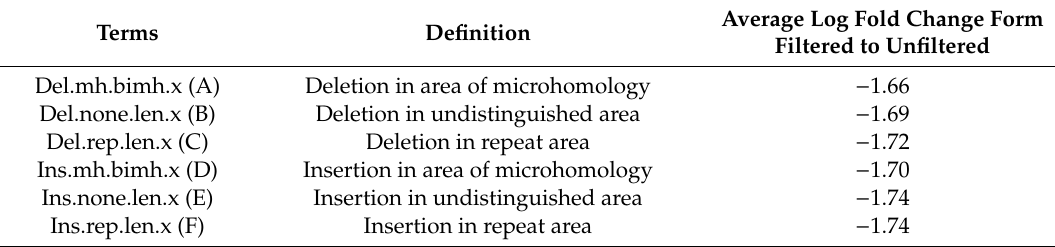
Figure 5. Mutational IR-induced signature plot (dataset 1). On the X-axis, the length and specific vicinity of InDels are represented, while the Y-axis (note differing scales) shows the InDel count. See Table 3 for pertaining terms and definitions. Table 3. Terms and definitions used for mutational signatures in Figure 5 and Appendix A Figure A7 with average fold change from unfiltered and filtered data.